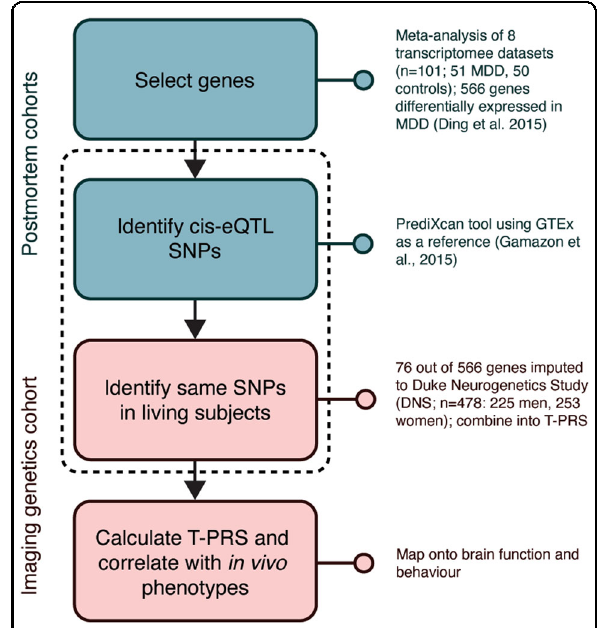
Fig. 1 Study design. A list of 566 genes associated with depression on the transcriptome-wide level was selected based on a prior meta- analysis of eight postmortem brain transcriptome datasets [11]. Building on reference data from the combined genomic – transcriptomic GTEx database, the PrediXcan tool, was then used to “ impute ” cortical expression of 76 of these genes based on 478 young adults participating in the Duke Neurogenetics Study (DNS). The imputed values for each of these genes were weighted by their original association with depression and summed into a polygenic risk score (T-PRS), such that higher values indicated a more depression-like transcriptome. This novel T-PRS was then mapped onto brain function during face